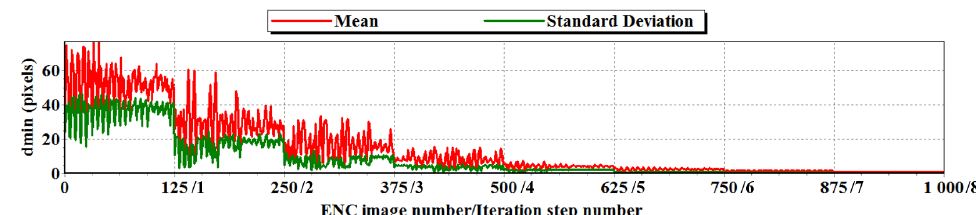
Figure 12. Graphs of the arithmetic mean and standard deviation dmin during the iteration process for photograph No. 1.